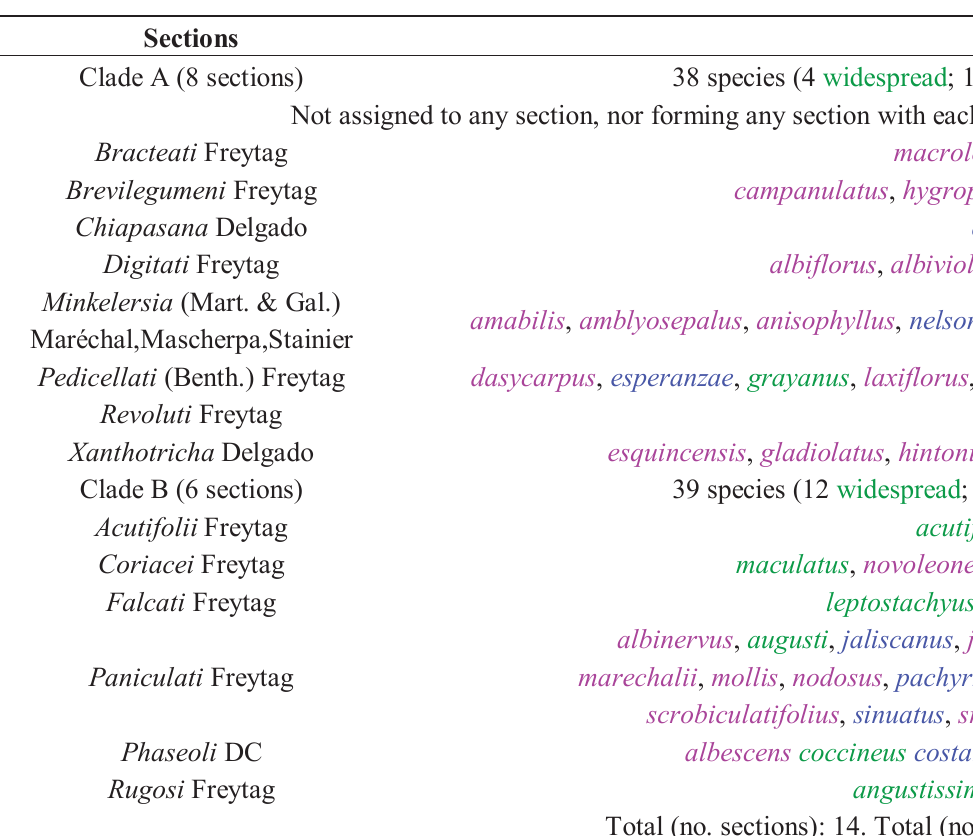
Table 1. Sections and species currently recognized in the genus (partly based on Delgado-Salinas et al. , 2006 [49]; Freytag and Debouck 2002